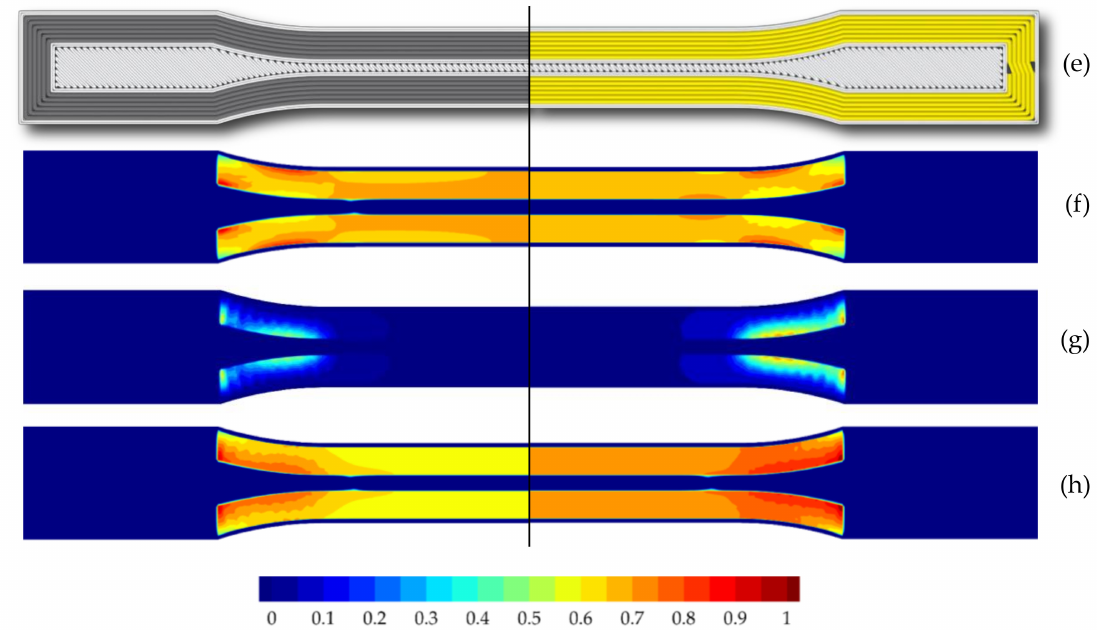
Figure 14. Comparison between damage predictions for the non-hybrid tensile specimen with carbon fiber reinforcement (100 CF ): ( a ) visualization of the G-code, ( b ) Hashin damage criterion–fiber tension F t , ( c ) Hashin damage criterion–matrix tension F t m , and ( d ) Tsai–Wu criterion; for the non-hybrid tensile f specimen with glass fiber reinforcement (100 GF ): ( e ) visualization of the G-code, ( f ) Hashin damage criterion–fiber tension F t , ( g ) Hashin damage criterion–matrix tension F t m , and ( h ) Tsai–Wu criterion; f Hashin and Tsai–Wu damage criterion, respectively, when reaching a value of ≥